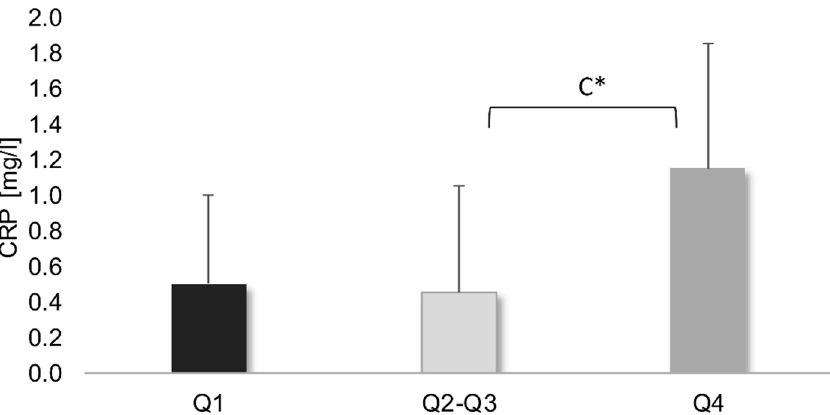
Figure 2. Protein C reactive (hs-CRP) concentration in men with different DII (median ± quartile).; C —significant differences between Q2–Q3–Q4; *— p < 0.05.